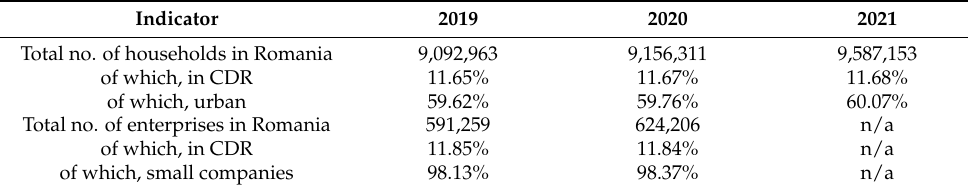
Table 2. Number of small businesses and household in Romanian CDR